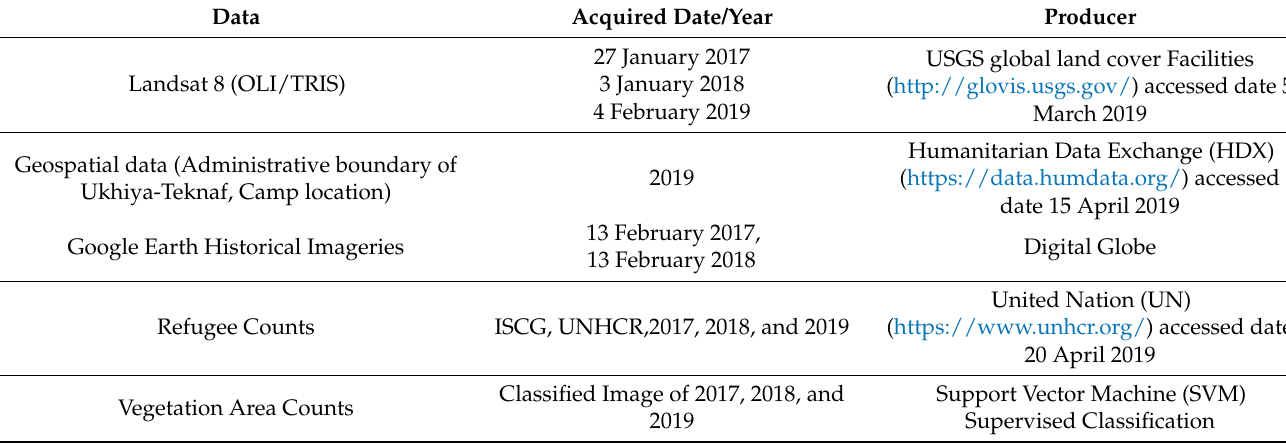
Table 1. Representations of the selected satellite, geospatial, and demographic data. OLI, Operational Land Imager; TIRS, Thermal Infrared Sensor; USGS, U.S. Geological